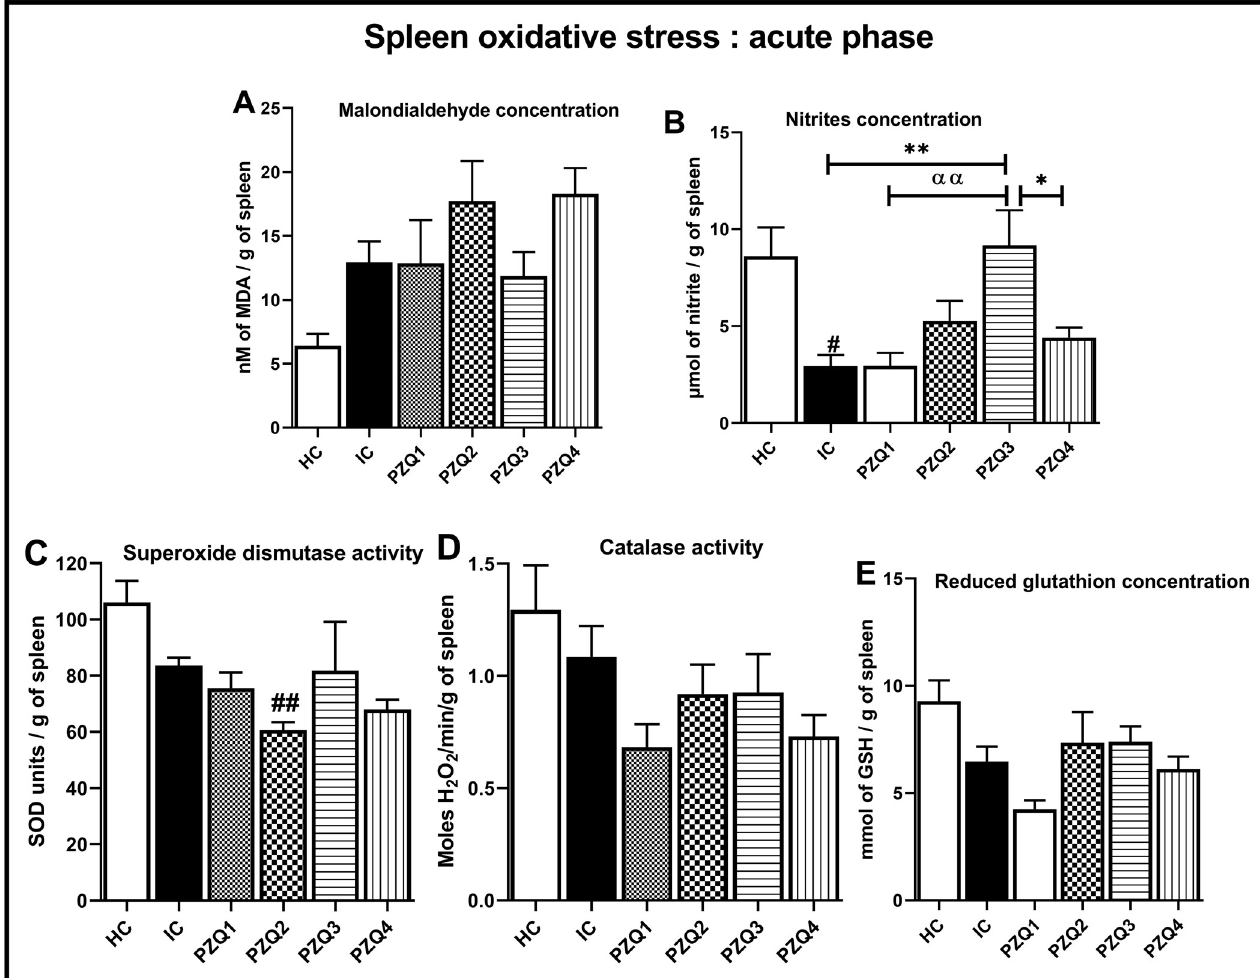
Fig 6. Effect of praziquantel treatment on the spleen oxidative status during the acute phase in Schistosoma mansoni -infected mice. (A) malondialdehyde, (B) nitrites, (C) superoxide dismutase, (D) catalase, and (E) Reduced glutathione. HC: Uninfected mice, IC: Infected-untreated mice, PZQ1: Infected mice treated with praziquantel at 100 mg/kg for 5 consecutive days, PZQ2: Infected mice treated with praziquantel at 100 mg/kg for 28 consecutive days, PZQ3: Infected mice treated with praziquantel at 18 mg/kg for 28 consecutive days, PZQ4: Infected mice treated with a single dose of praziquantel at 500 mg/kg. Data are expressed as mean ± SEM (n = 6). ANOVA followed by Tukey multiple comparison test was also used for statistical analysis. ## p < 0.01: values are significantly different from those uninfected mice (group HC). � p < 0.05, �� p < 0.01: values are significantly different from those of infected-untreated mice (group IC). αα p < 0.01: values are significantly different from those of infected mice treated with PZQ3 posology (group